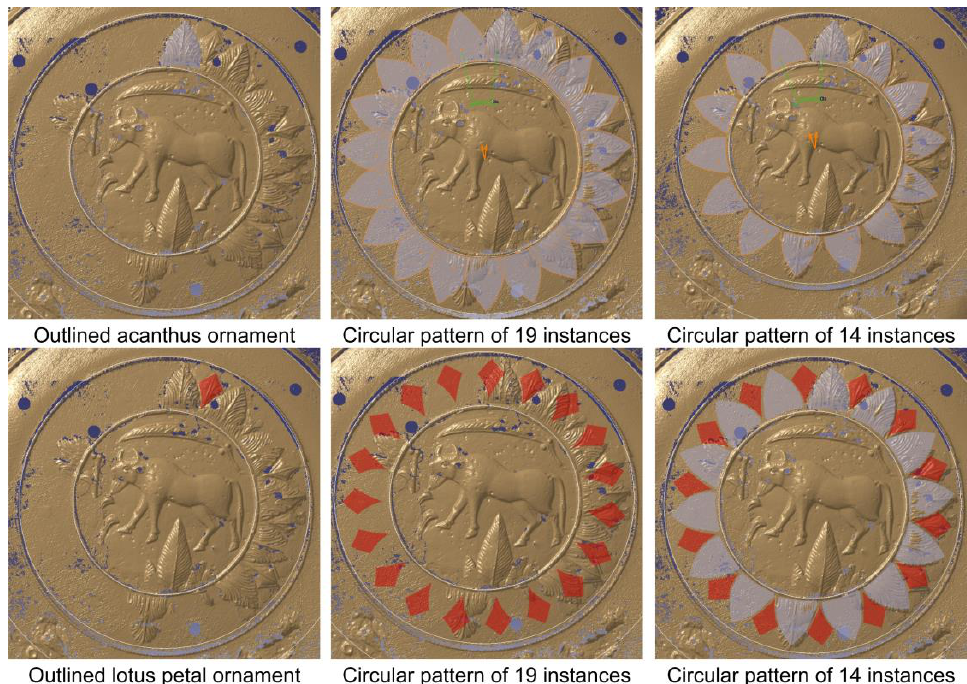
Figure 16. Patterned ornaments around the central register.